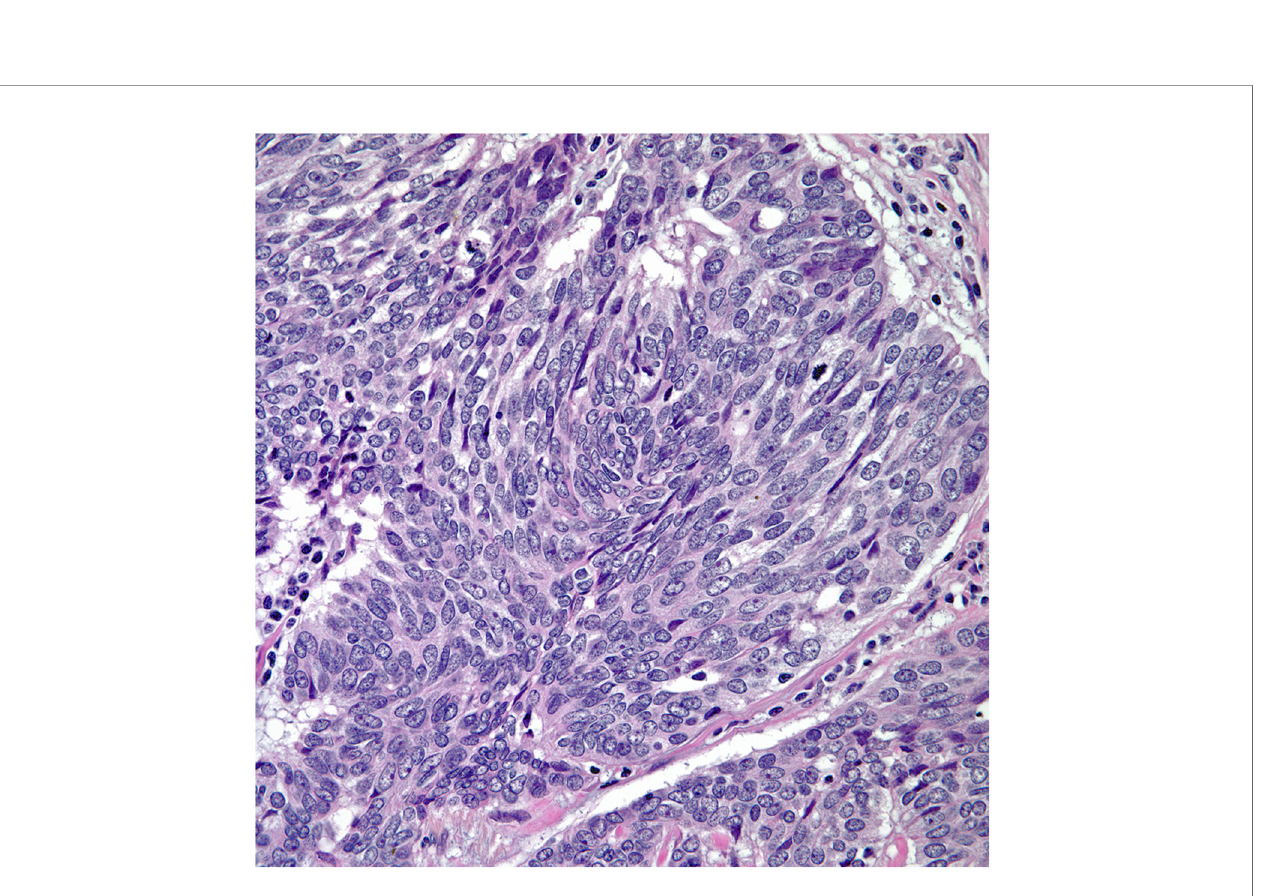
FIGURE 3 | Thymic sarcomaoitd